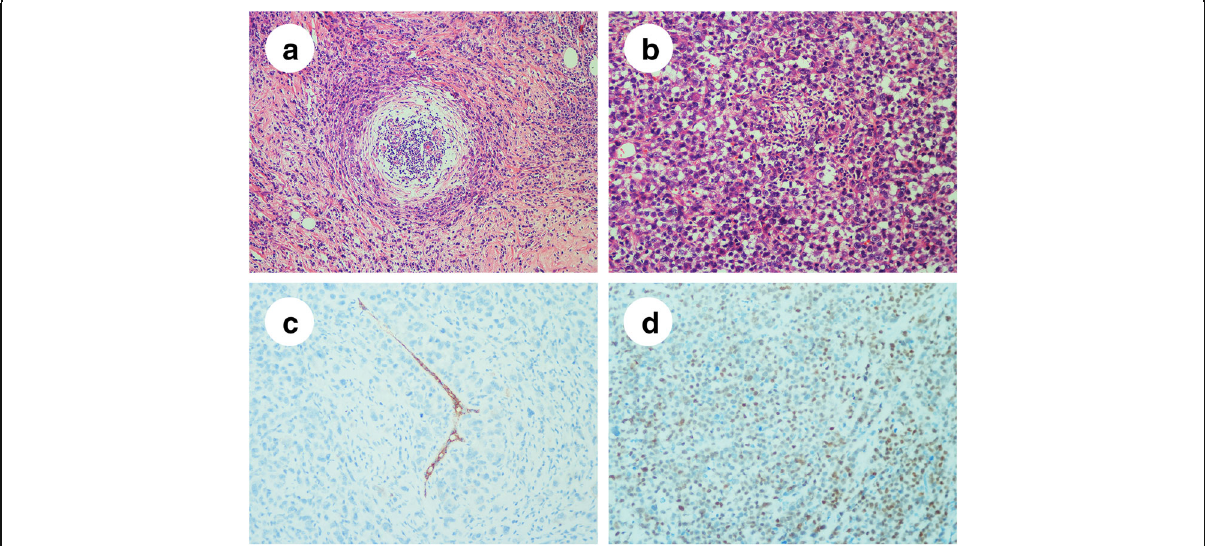
Fig. 3 Photomicrograph of the primary breast lesion. a : The malignant tumor cells showing a targetoid growth pattern or arranging in the form of solid sheets and single files (H&E, ×100). b : Abundant and eosinophilic cytoplasm of the cells, with nuclei of increased size and nucleolar prominence (H&E, ×200). c : Negative E-cadherin immunostaining of tumor cells with positive internal control in the residual duct (Envision, ×200). d : Moderate to strong nuclear staining for GATA3 (Envision,